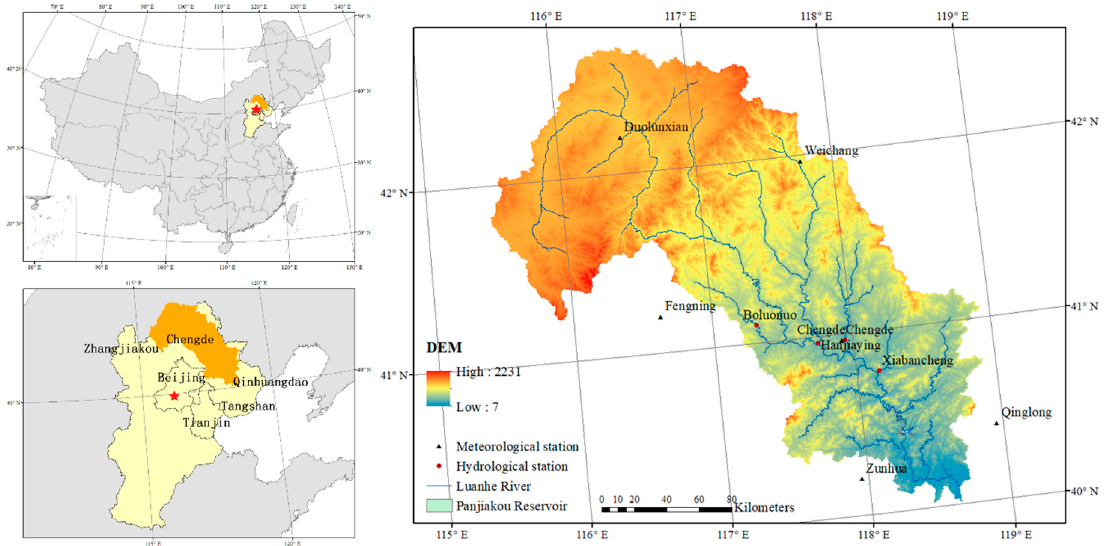
Figure 1. Location of the Luanhe river with hydrological and meteorological stations.